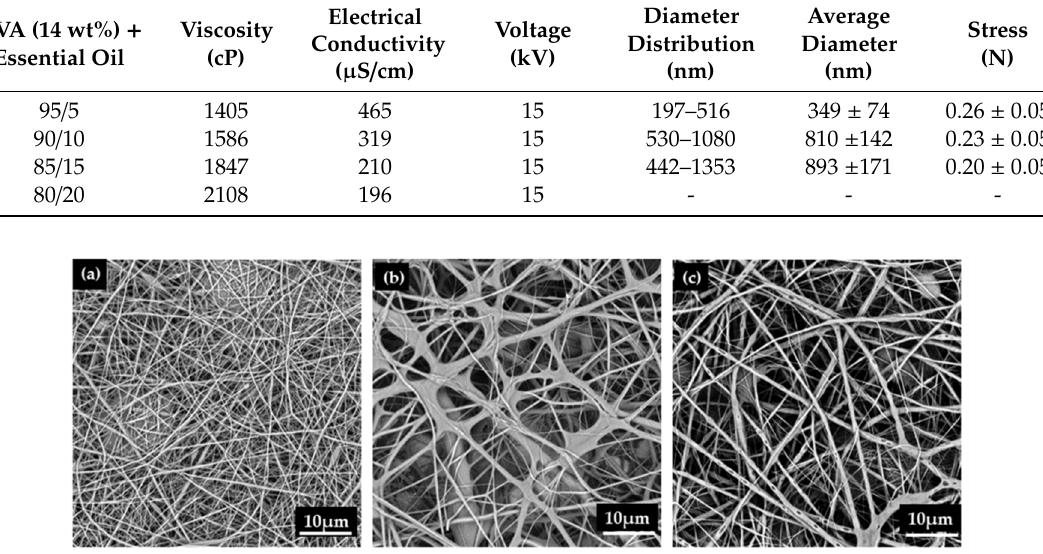
Figure 4. SEM image of PVA/EGO nanofibrous membranes made at a specified spinning voltage of 15 kV. The PVA/EGO ratios are ( a ) 95/5, ( b ) 90/10, and ( c ) 85/15.